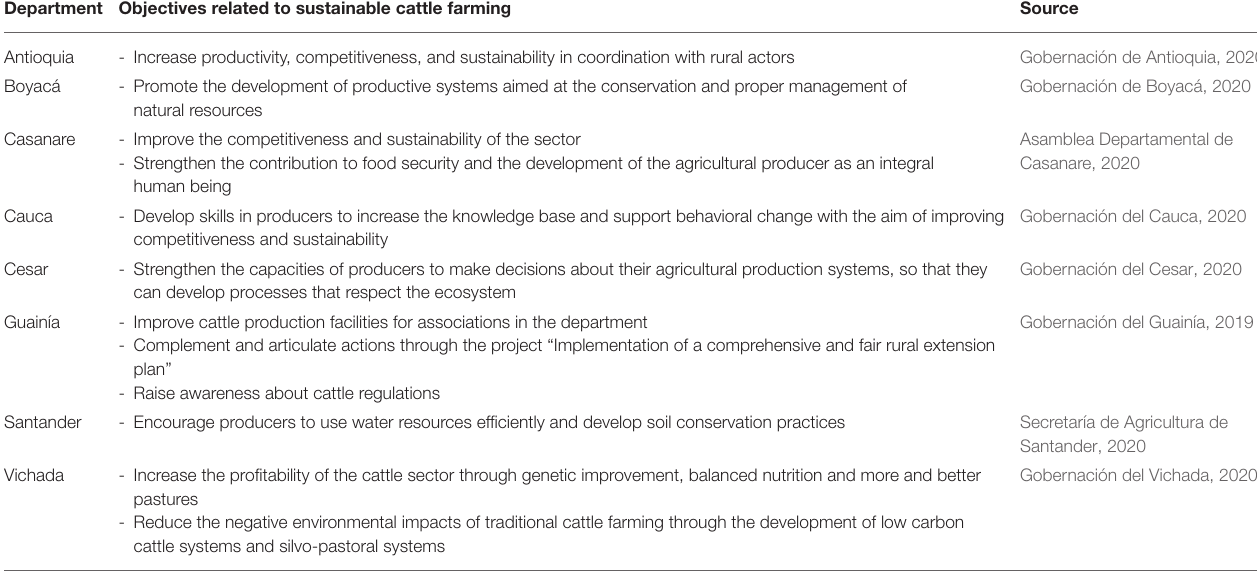
TABLE 1 | Overview on the objectives and geographical reach of the Departmental Agricultural Extension Plans (PDEA) in